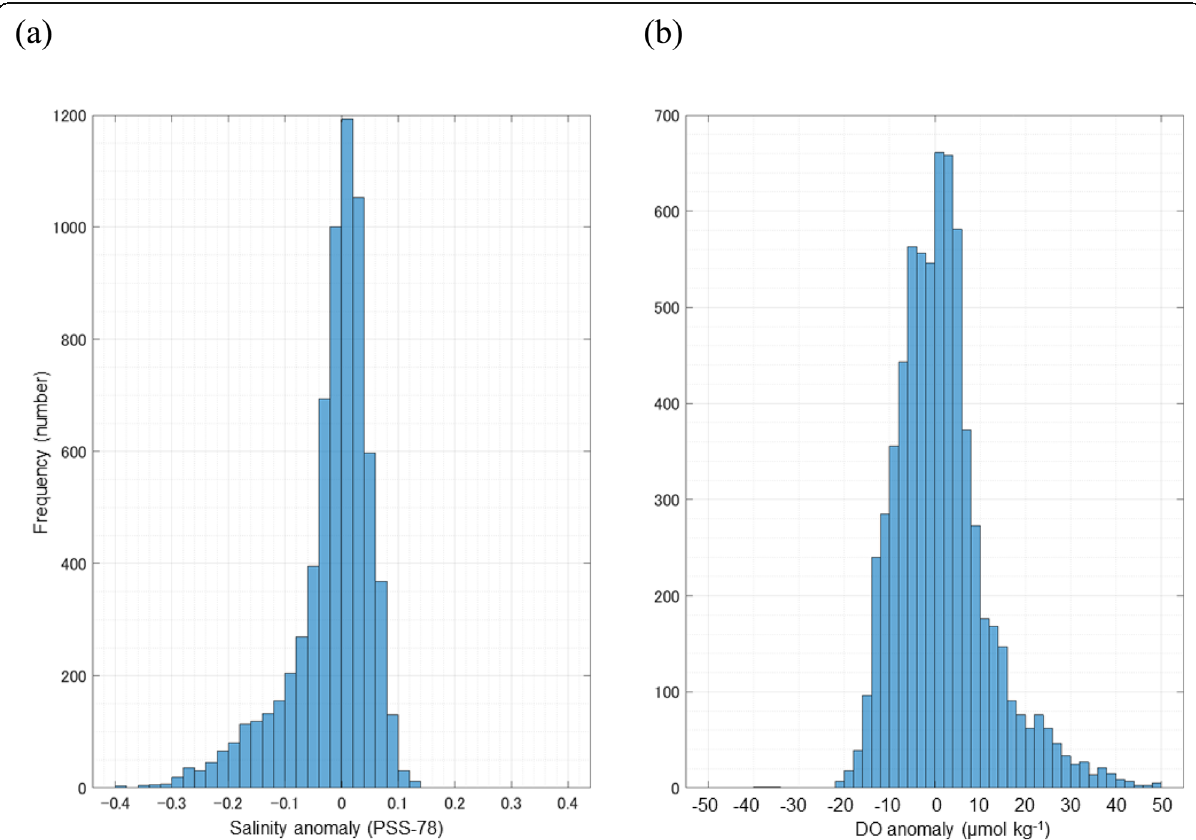
Fig. 6 Histograms in a the salinity anomaly (PSS-78) and b DO anomaly ( μ mol kg − 1 ) among 26.2 – 26.8 σ θ isopycnal levels. Frequency is counted based on the horizontally and vertically gridded data. Horizontal interval is interpolated every 1 km, while the vertical one is every 0.01 σ θ . Histograms in a and b are separated every 0.2 and 2 μ mol kg − 1 bins, respectively. Medians of salinity and DO anomalies are − 0.00014 and 0.71, respectively. Mean salinity and DO anomalies are − 0.018 and 1.8,